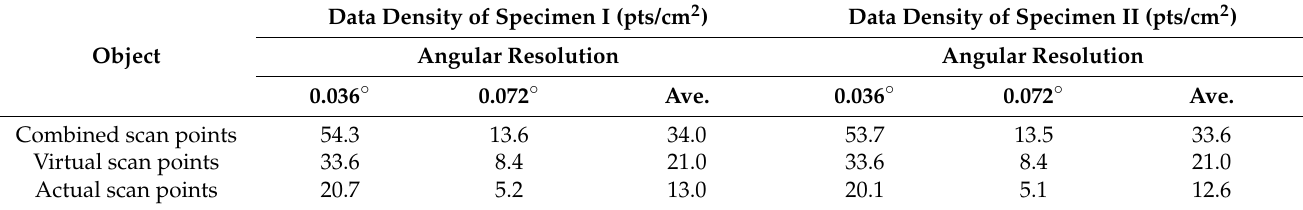
Table 5. Scan density varying angular resolutions with different scanning distances of combined scan points, virtual scan points and actual scan